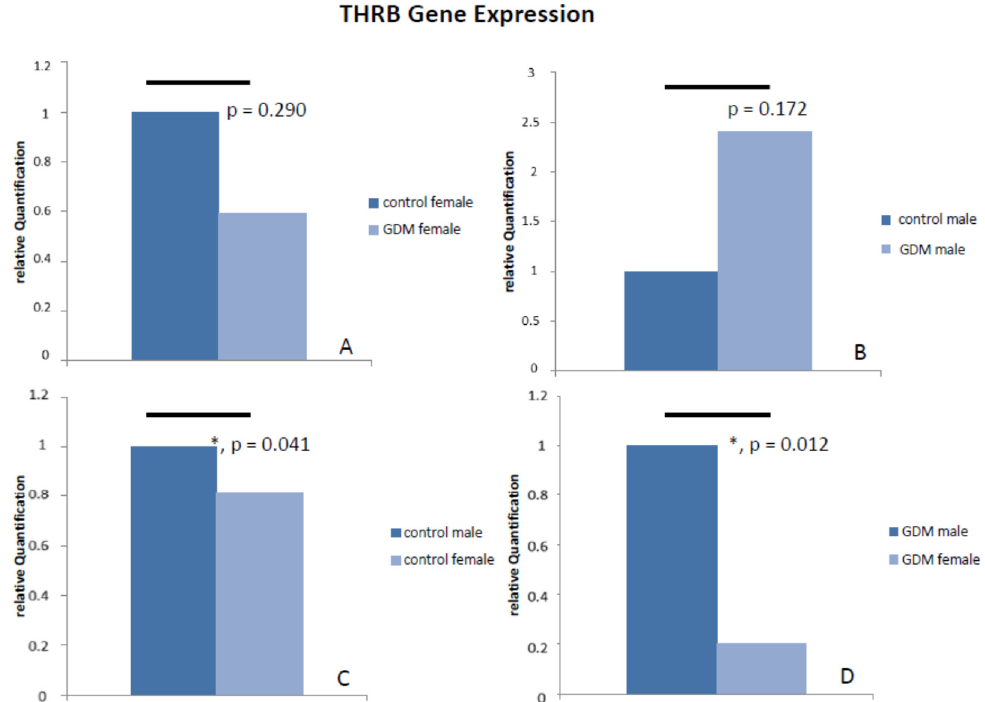
Figure 8. Results of THRB gene expression analysis with TaqMan RT-PCR. There was no significant di ff erence in THRB gene expression between GDM and control placental tissue: ( A ) shows THRB gene expression for female GDM placenta and ( B ) for male GDM placenta in comparison to control. THRB mRNA levels were lower in female placental tissue in comparison to male, both in controls ( C ) and even more in GDM ( D